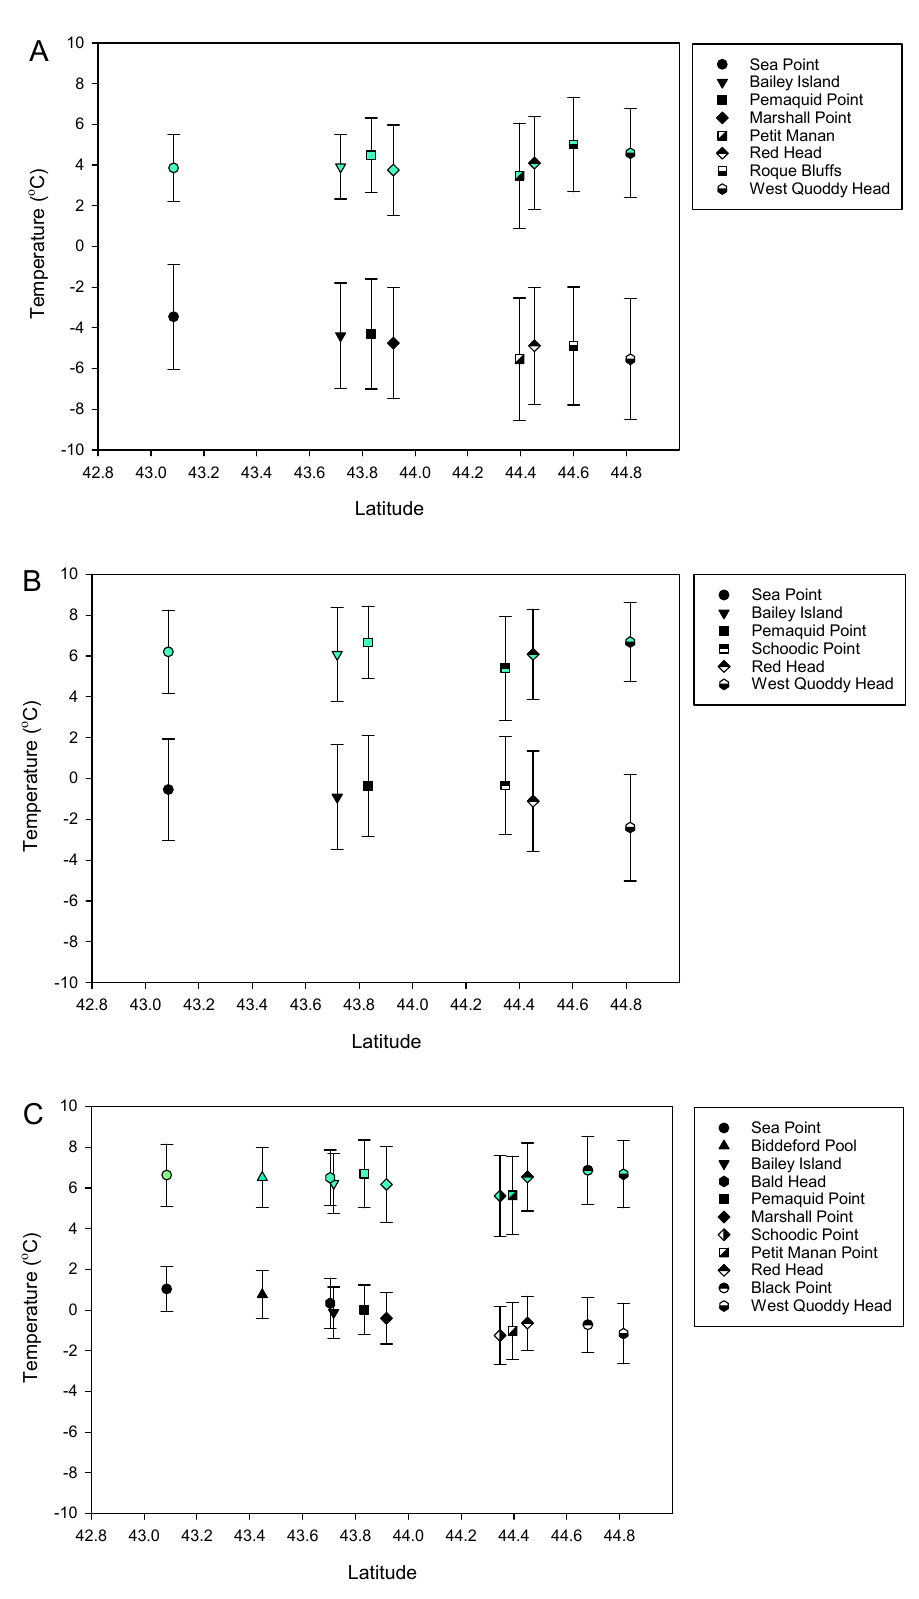
Figure 3. Winter temperature ( x ± SE) profiles for the GoM study area. ( A ), 2004; ( B ), 2007; ( C ), 2012. Symbology: Coastal land 2 m air temperature, black symbols; sea surface temperature, green symbols; filled symbols correspond to southern GoM region; half-filled symbols correspond to the northern GoM region.